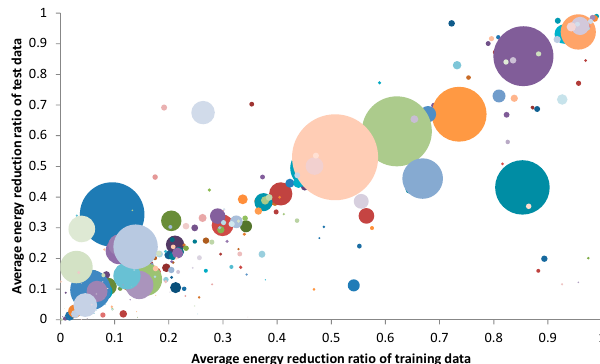
Figure 4. Distribution of the average energy reduction ratio of 307 customers. The average reduction ratio of the training data shows a similar result to that of the test data. This means that the past reduction ratio can be used to predict a future reduction ratio. The absolute value of possible reduction is represented by its radius.